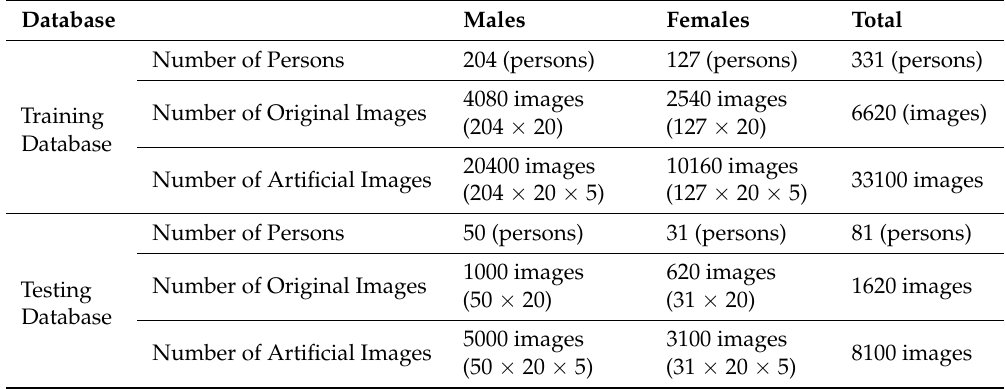
Table 3. Description of the training and testing databases in our